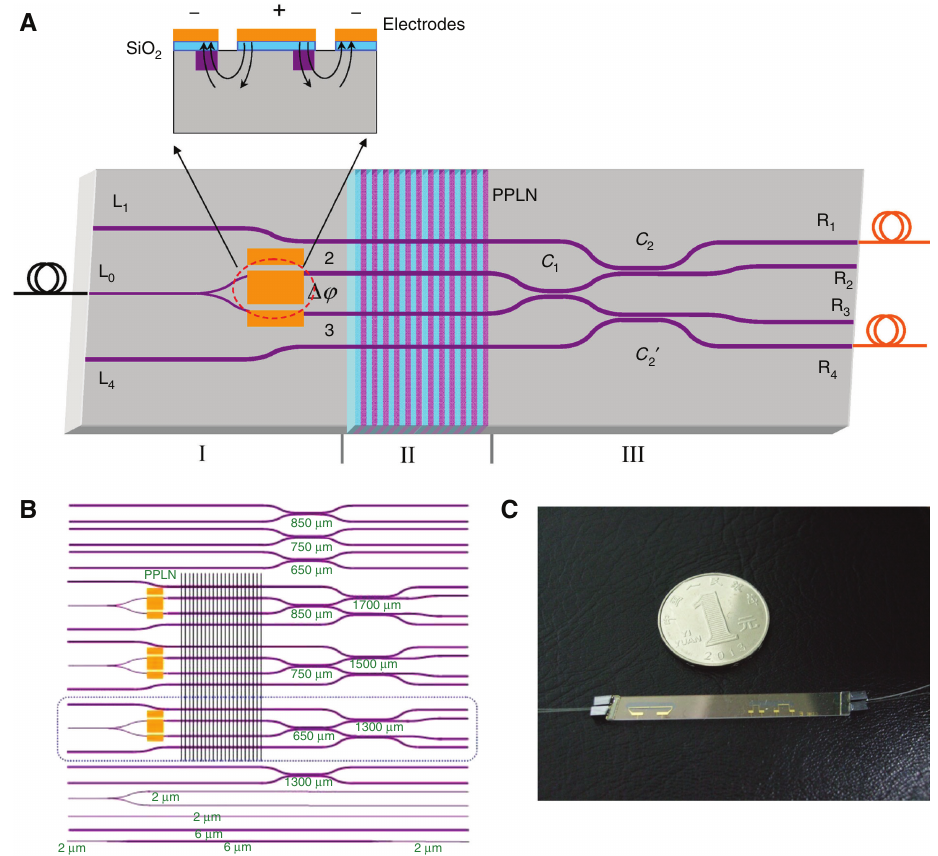
Figure 24: The photonic chip for generating and manipulating entangled photons. (A) Schematic diagram of this chip. Top inset: cross-section view of the electro-optic modulator. (B) Overview of the chip. (C) Photograph of the chip. Reprinted figure with permission from Jin et al. [196]. Copyright (2019) by the American Physical